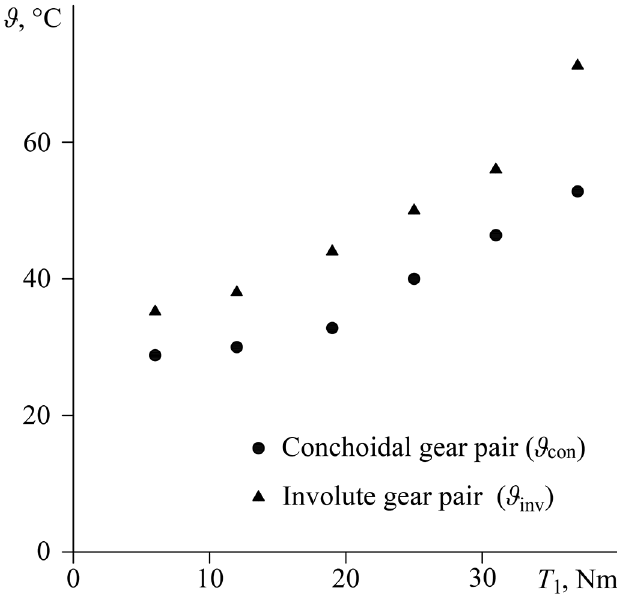
Fig. 8. Gear box oil temperature # vs pinion torque T 1